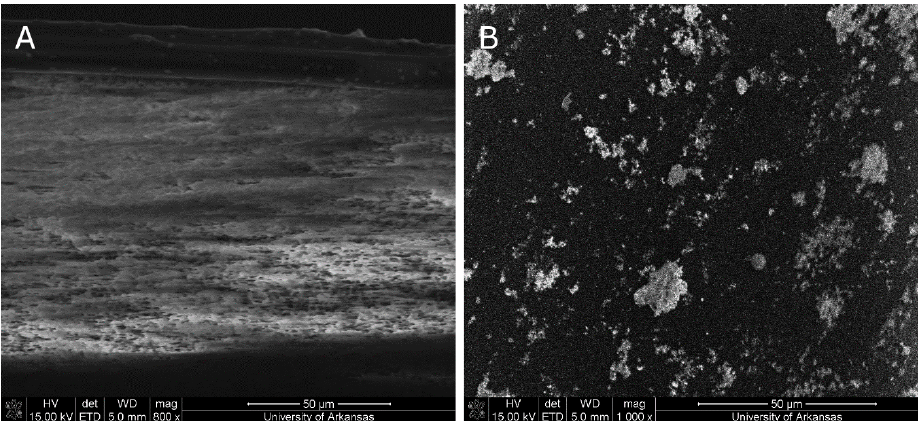
Figure 2. SEM micrograph of ( A ) PVA-Ag cross-section; ( B ) PVA-Ag top (coated) surface.